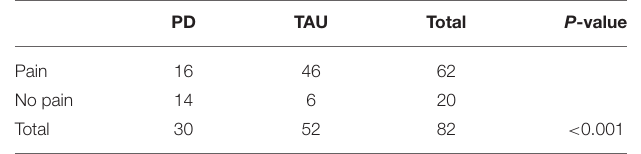
TABLE 4 | Shows the resolution of pain between the PD and TAU